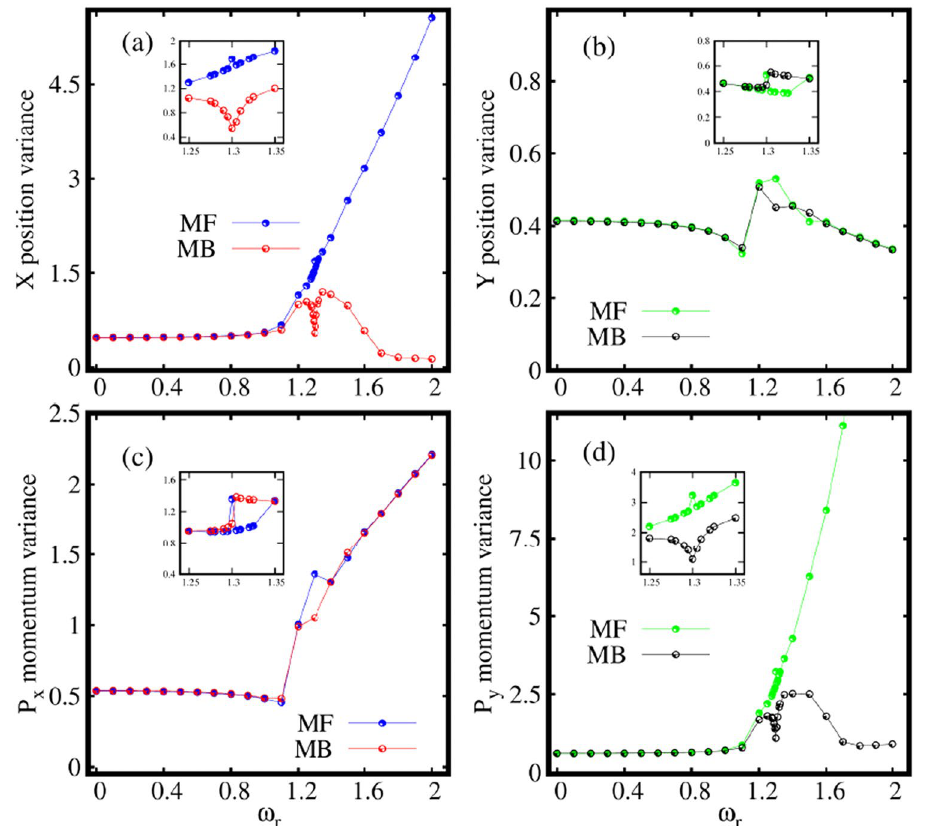
, and ( d ) 1 N (cid:31) 2 ˆ P as a function of ω r at the many-body X Y